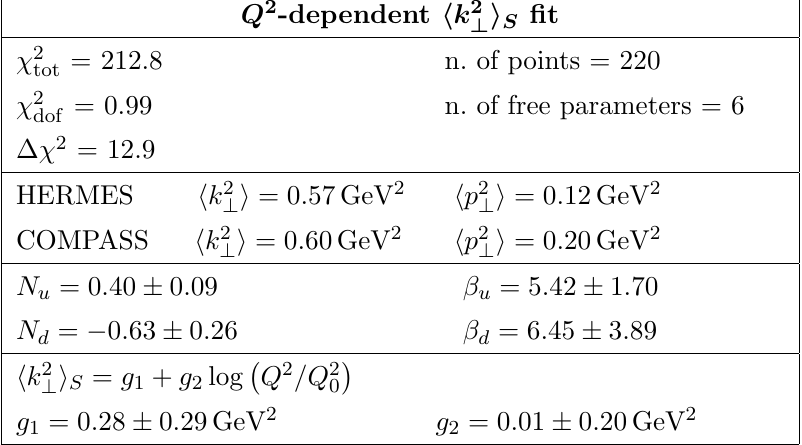
Table 5 . Best (cid:12)t parameters and (cid:31) 2 values for the Q 2 -dependent h k 2 i S case, in which our reference ? model is modi(cid:12)ed according to eq. (5.1). The parameter errors correspond to 2 (cid:27) C.L. Notice that there is no reduction in the value of (cid:31) 2 w.r.t. that of the reference (cid:12)t in table tot